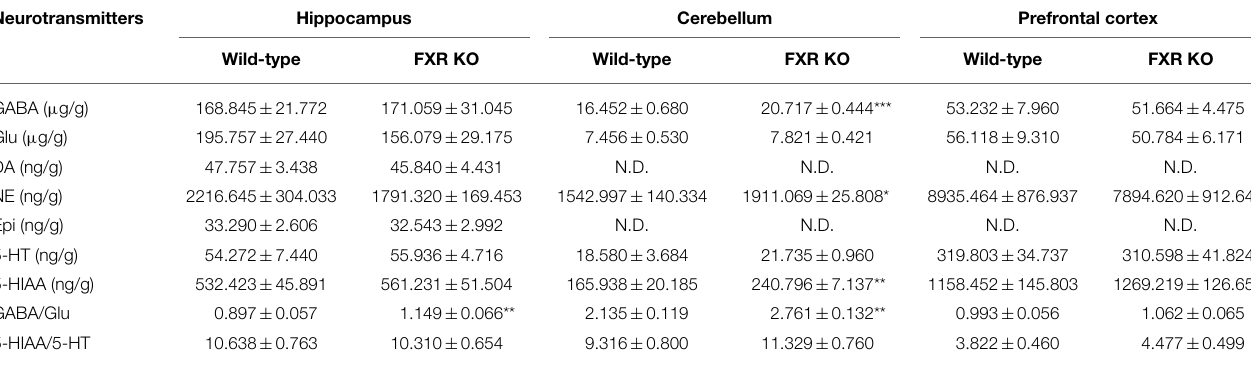
TABLE 1 | Comparisons of neurotransmitter concentrations in mouse hippocampus, cerebellum, and prefrontal cortex (mean ±